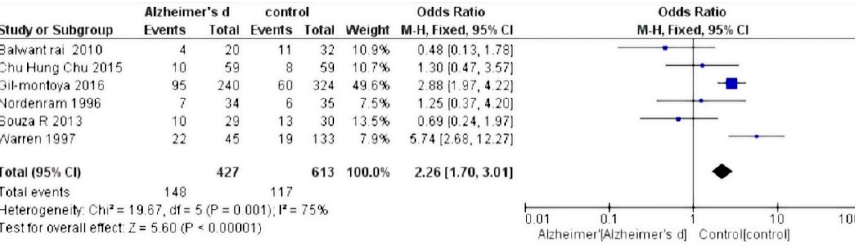
Figure 2. Forest plot of random effects models of the meta-analysis. Outcome: missing teeth. ff ects models of the meta-analysis. Outcome: Figure 3. Forest plot of fixed effects models of the meta-analysis. Outcome: edentulism. Figure 3. Forest plot of fixed e